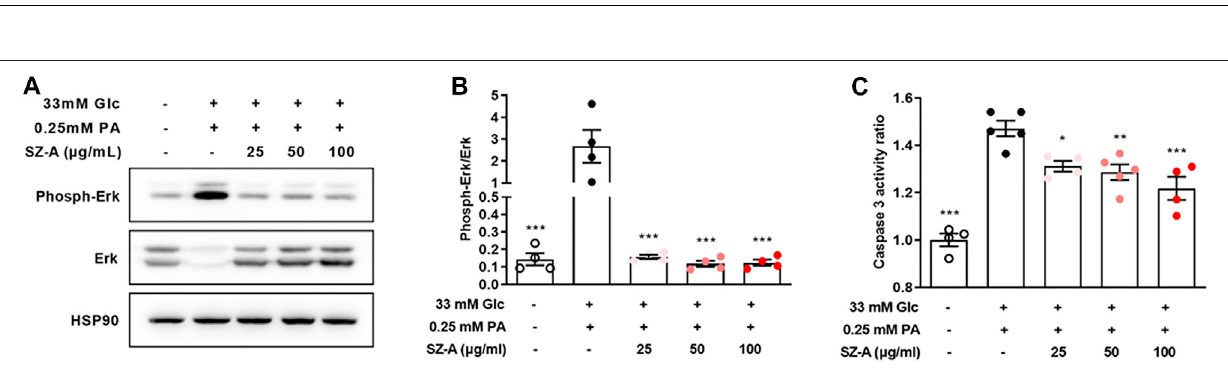
increased TUNEL-positive cells. SZ-A did not in fl uence cell proliferation in basic culture medium (25 mM glucose) but signi fi cantly reversed the growth inhibition of MIN6 cells induced by high glucose and palmitic acid ( Figure 4E ).